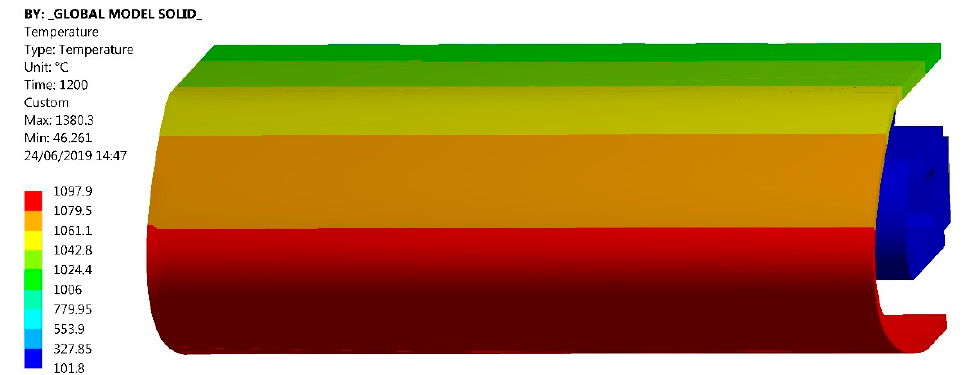
Figure 9. Temperature contour plot at 1200 seconds -Global coarse solid model.